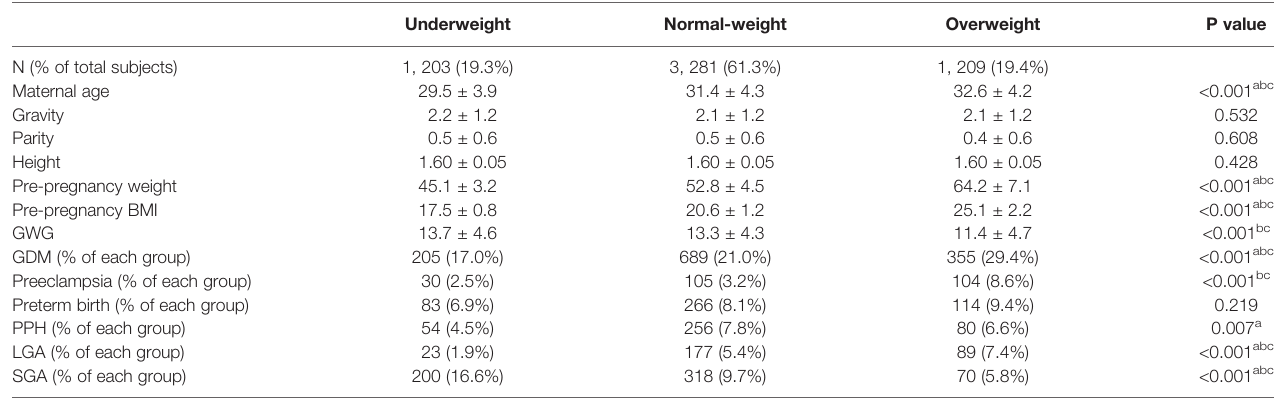
TABLE 1 | Basic characteristics and obstetric outcomes of subjects included in the study (N =6,